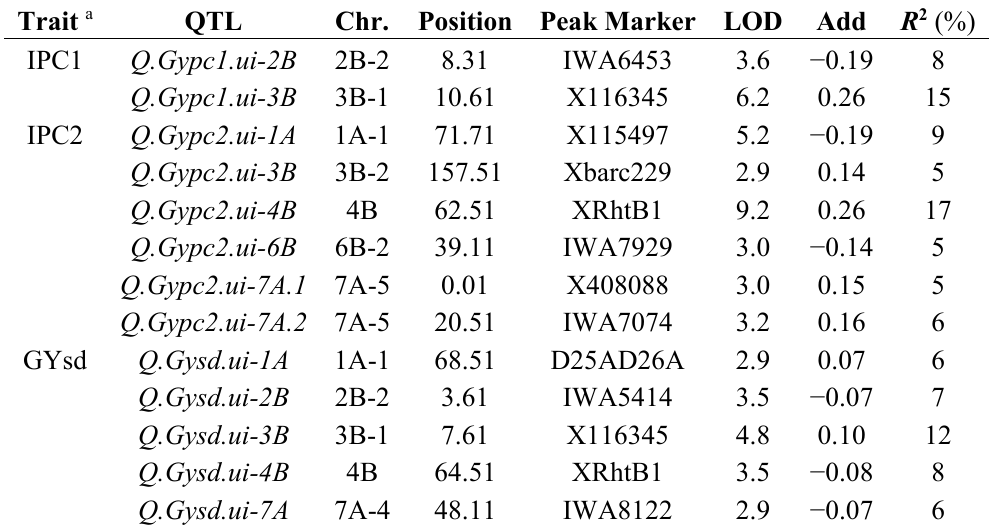
Table 4. QTL identified for genotype × environment interaction of grain yield. Trait